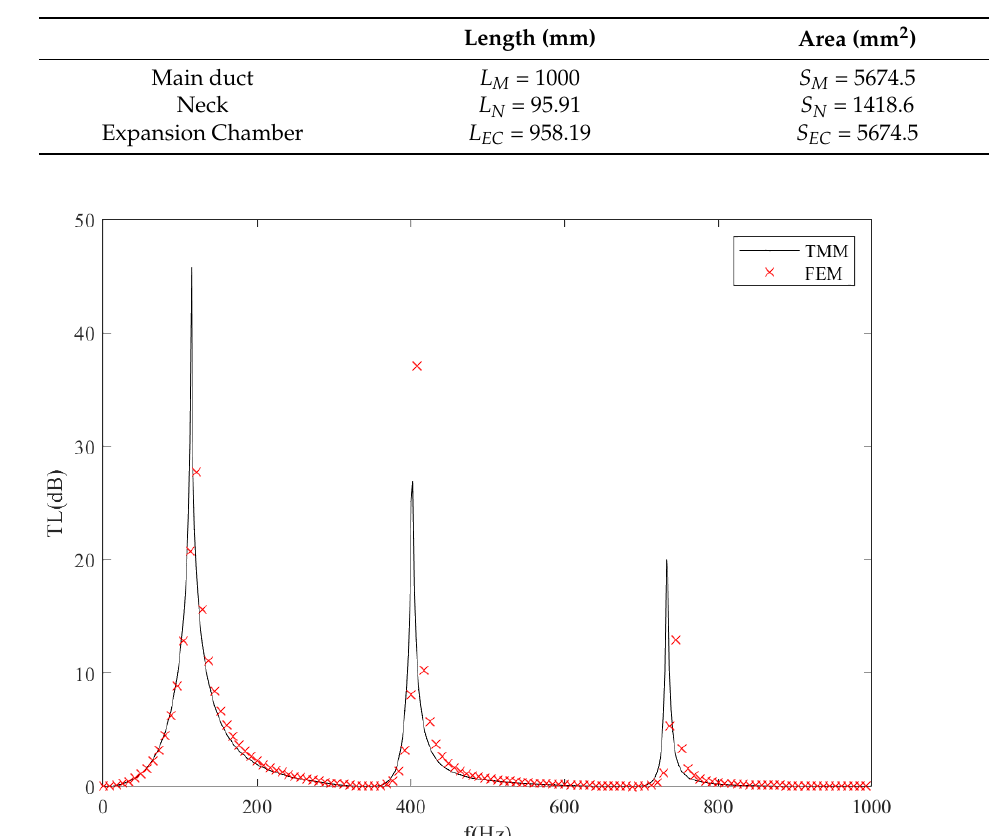
Table 1. Parameters of the ITEC model for simulation.